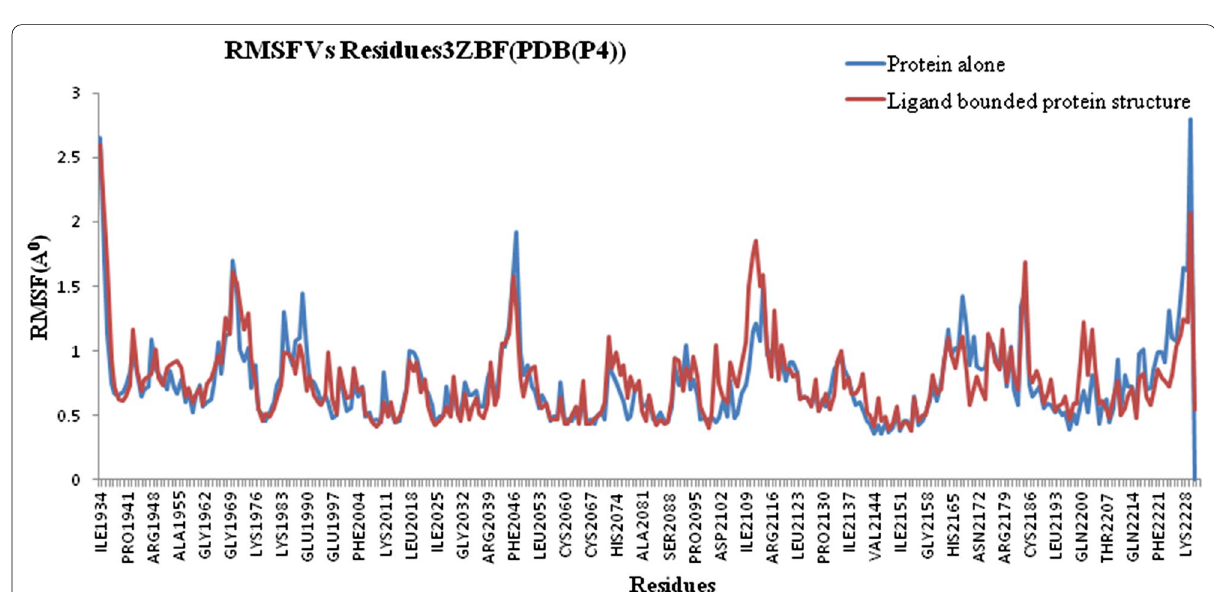
Fig. 7 RMSF graph based on ligand-free protein and ligand bounded protein complex of C-ROS1